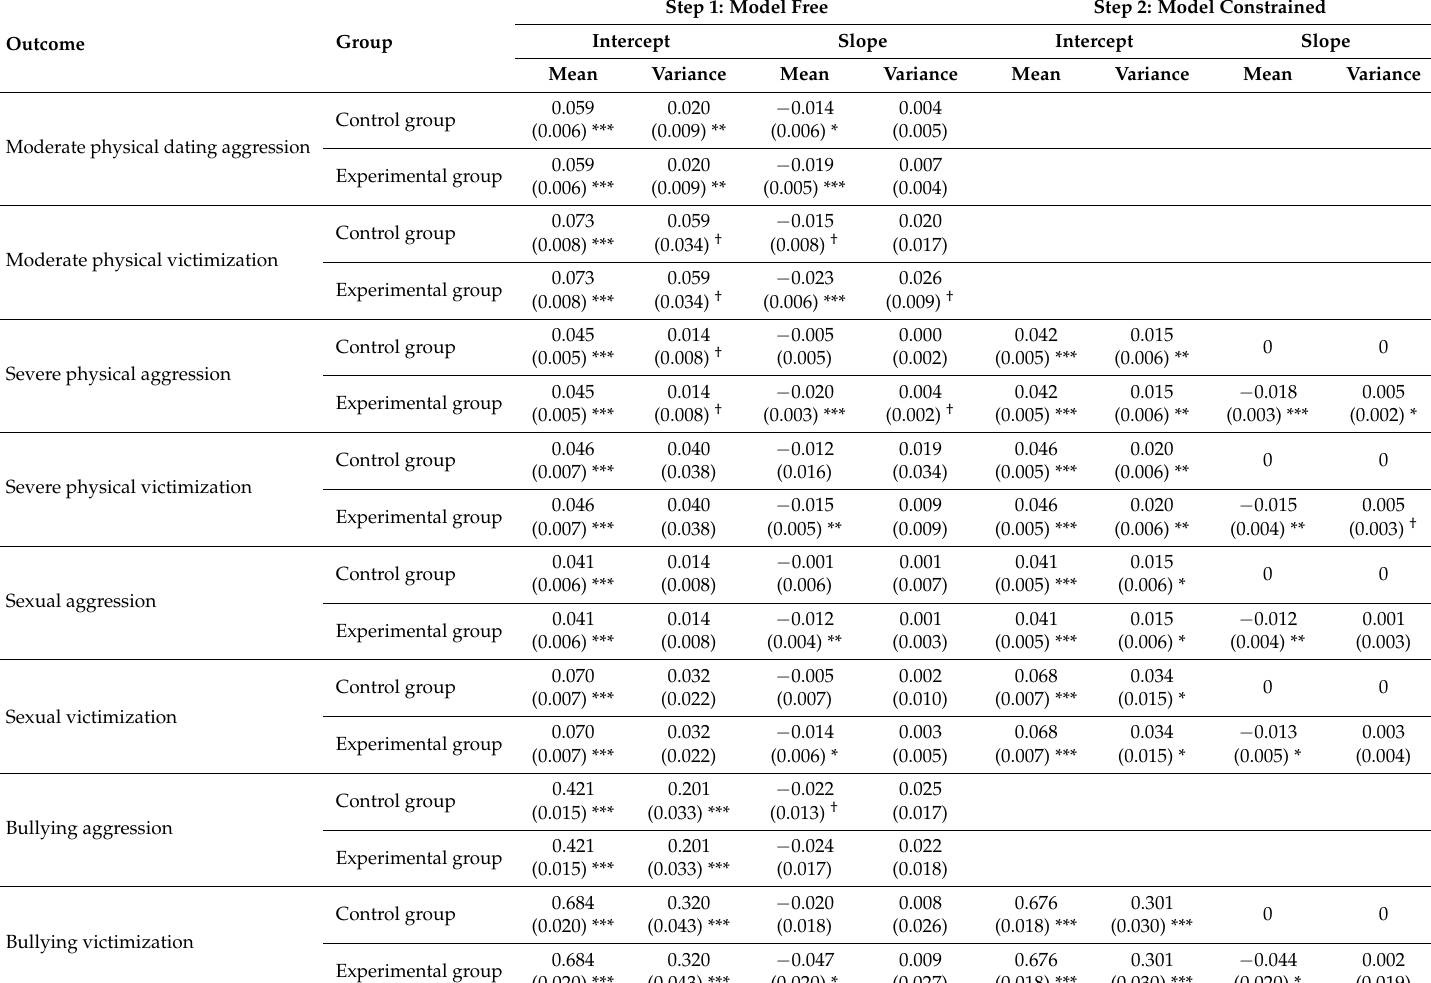
Table 4. Multiple-group estimated components of growth